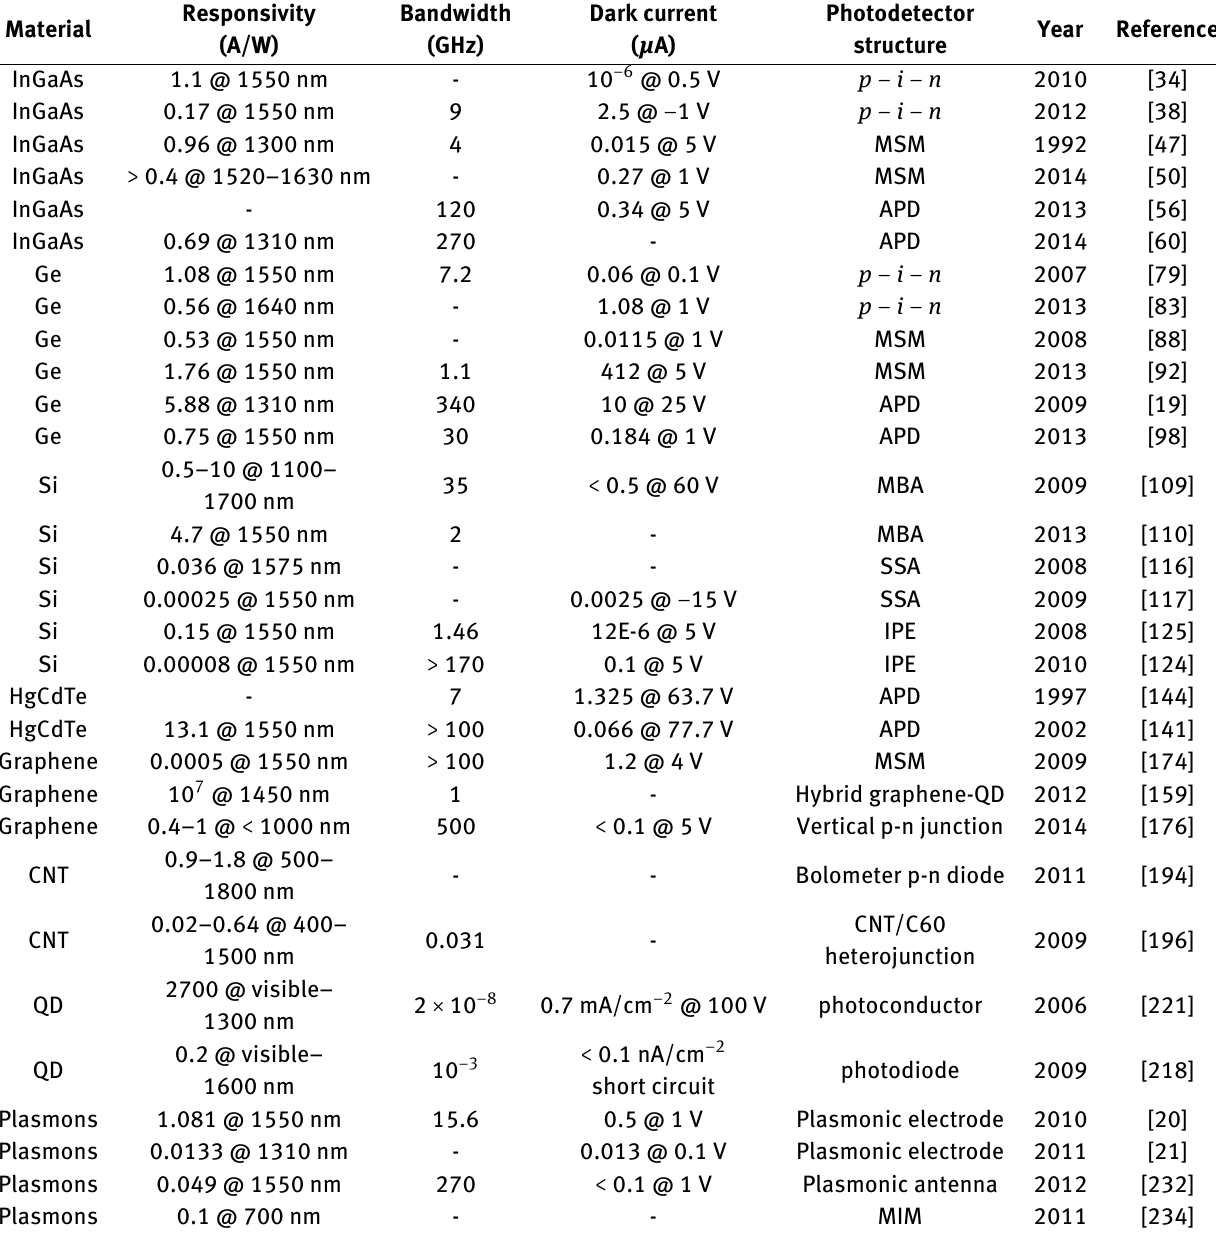
Table 1: Performance comparison for photodetectors based on various material systems.